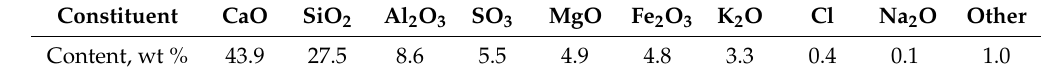
Table 2. Chemical composition of the oil shale laboratory ash.